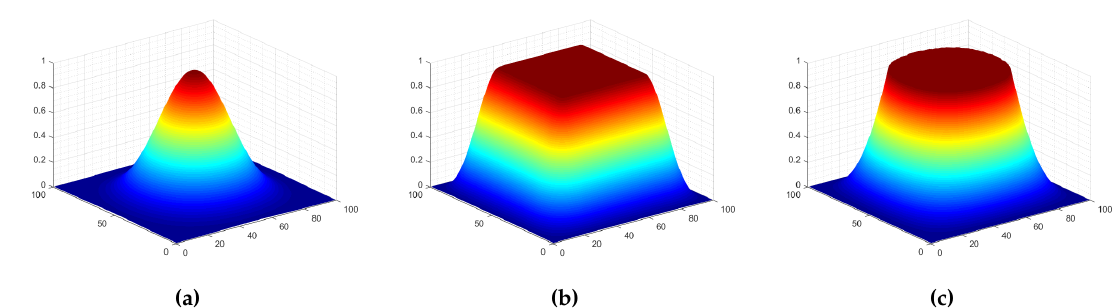
Figure 1. The three-dimensional diagrams of different window functions. ( a ) is the diagram of Blackman window function; ( b ) is the diagram of raised-cosine window function; ( c ) is the diagram of flap-top window function. The length of all window functions is 100. For raised-cosine window function, its roll-off factor β is set to 0.25. For the flap-top window function, its stretch factor k is set to